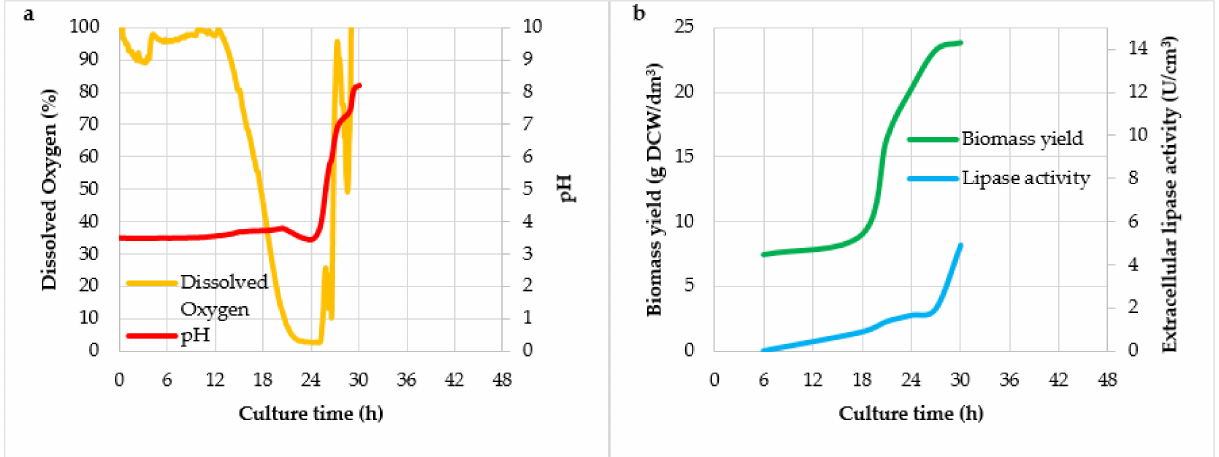
Figure 4. Kinetics of dissolved oxygen and pH ( a ) and biomass yield and extracellular lipase activity ( b ) of the yeast strain Y. lipolytica KKP 379 in the culture with an agitation speed of 600 rpm and air flow of 2 dm 3 /(dm 3 ×